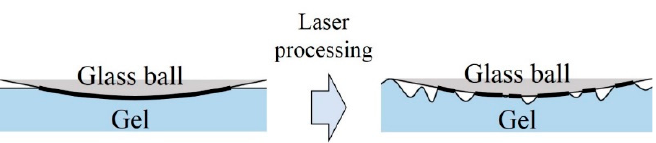
Figure 4. Schematic illustration of the difference between before and after laser processing in the case of the glass ball and hydrogel interface. Bold curves represent the true contacting interface.